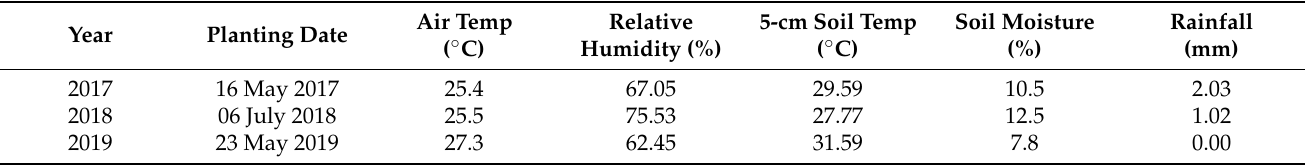
Table 3. Mean air temperature, relative humidity, 5-cm soil temperature, soil moisture averaged across 5 days after planting and total rainfall during the 5 days after planting in 2017, 2018 and